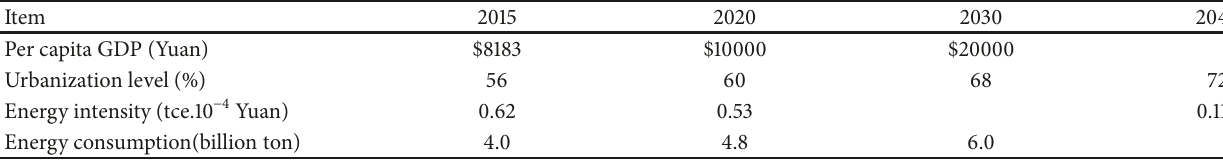
Table 1: The values of factors for measuring the CO2 emission peak in